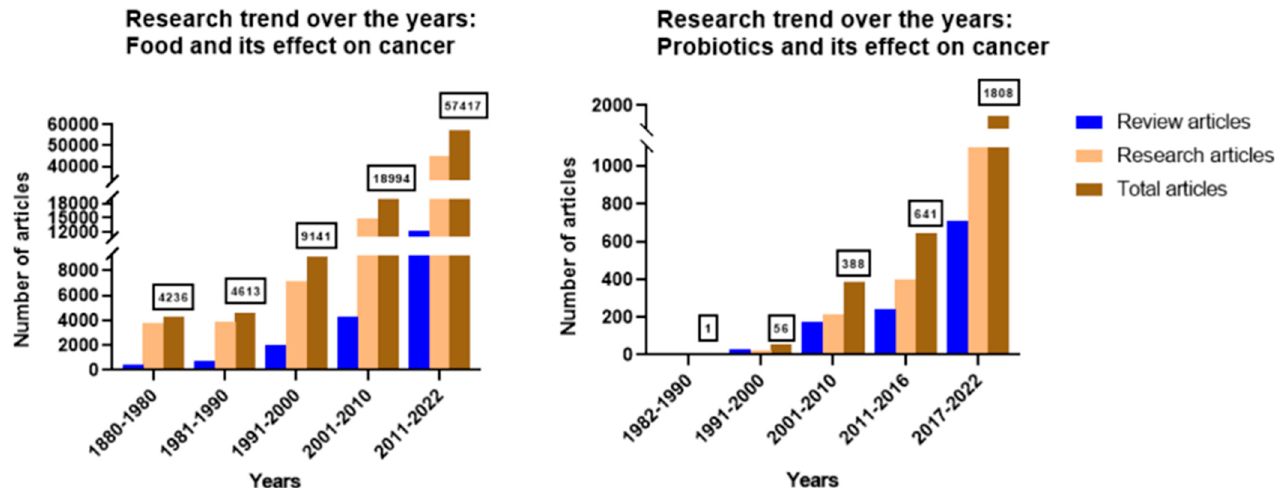
Figure 1. Research trend of food and its association with cancer over the years ( left ); research trend of probiotics and cancer over the years ( right ). The data related to the number of publications was curated from the PubMed database (https://pubmed.ncbi.nlm.nih.gov/, accessed on 1 June 2022). (Figure created with Biorender.com (https://biorender.com/, accessed on 1 June 2022) and GraphPad Prism, version 9.4.1 (GraphPad Software, San Diego, CA, USA)).